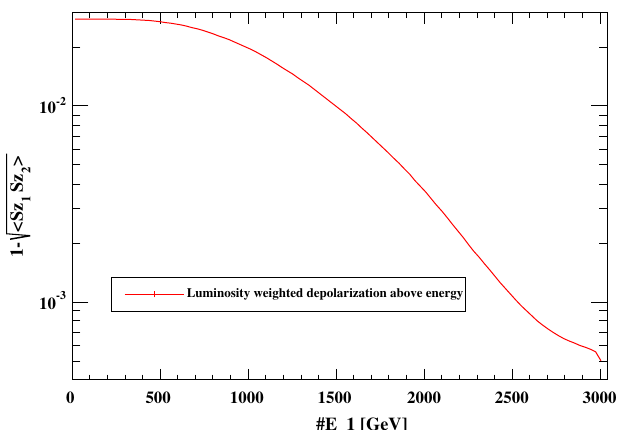
FIG. 16. The CLIC depolarization as function of a cut in the lower CM